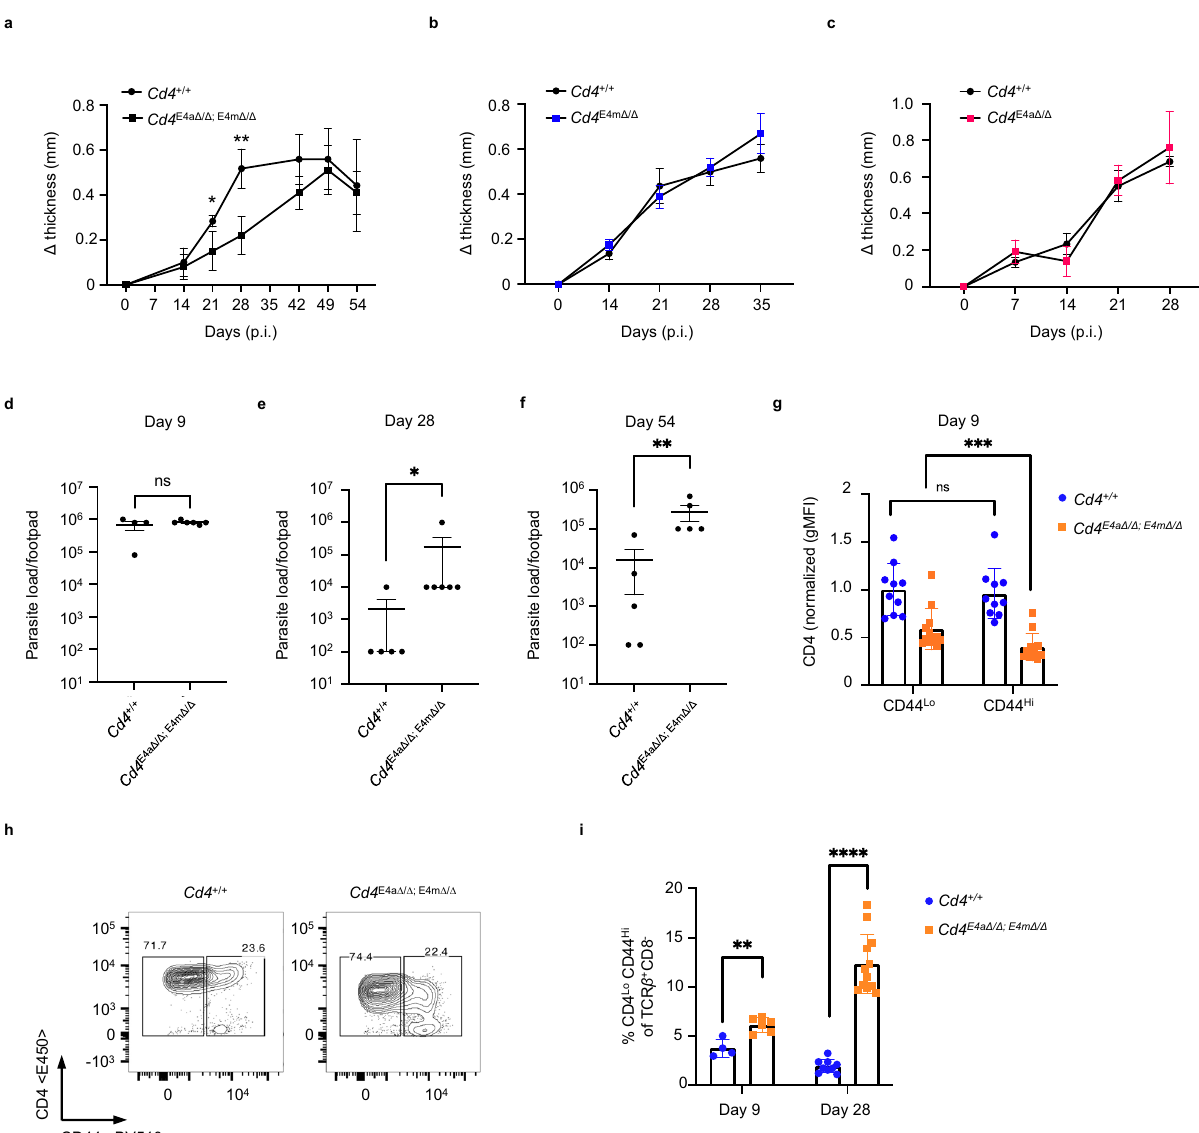
Fig. 5 Reduced CD4 expression in effector CD4 T cells impairs parasitic clearance during Leishmaniasis. a – c Footpads of indicated genotypes were infected with 2×10 6 L. major promastigotes. Footpad swelling was measured over days post infection (p.i). a ( n = 12 for Cd4 + / + ; n = 10 for Cd4 E4m Δ / Δ / E4a Δ / Δ ) and is a summary of three independent experiments. Data shown is mean ± SEM. * p = 0.047619, ** p = 0.006494 (multiple Mann – Whitney